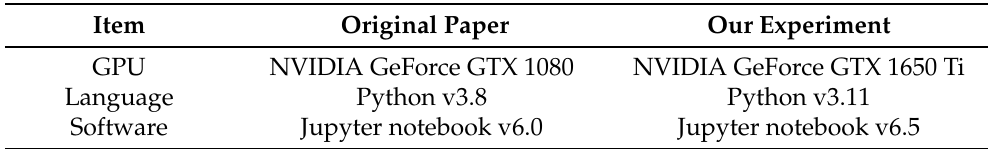
Table 5. A summary of the environment used by the original paper and the reproduced experiment. The version of Python and Jupyter notebook of the original paper were deduced by the date of the submission of the paper and the date of the source code uploaded on